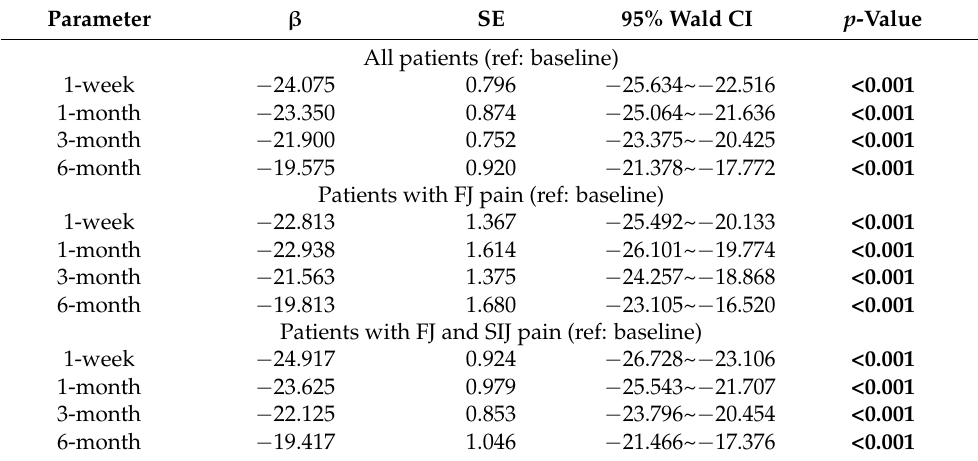
Table 3. Improvements in ODI score from baseline to follow-up visits estimated by GEE after adjusting for age, gender, and